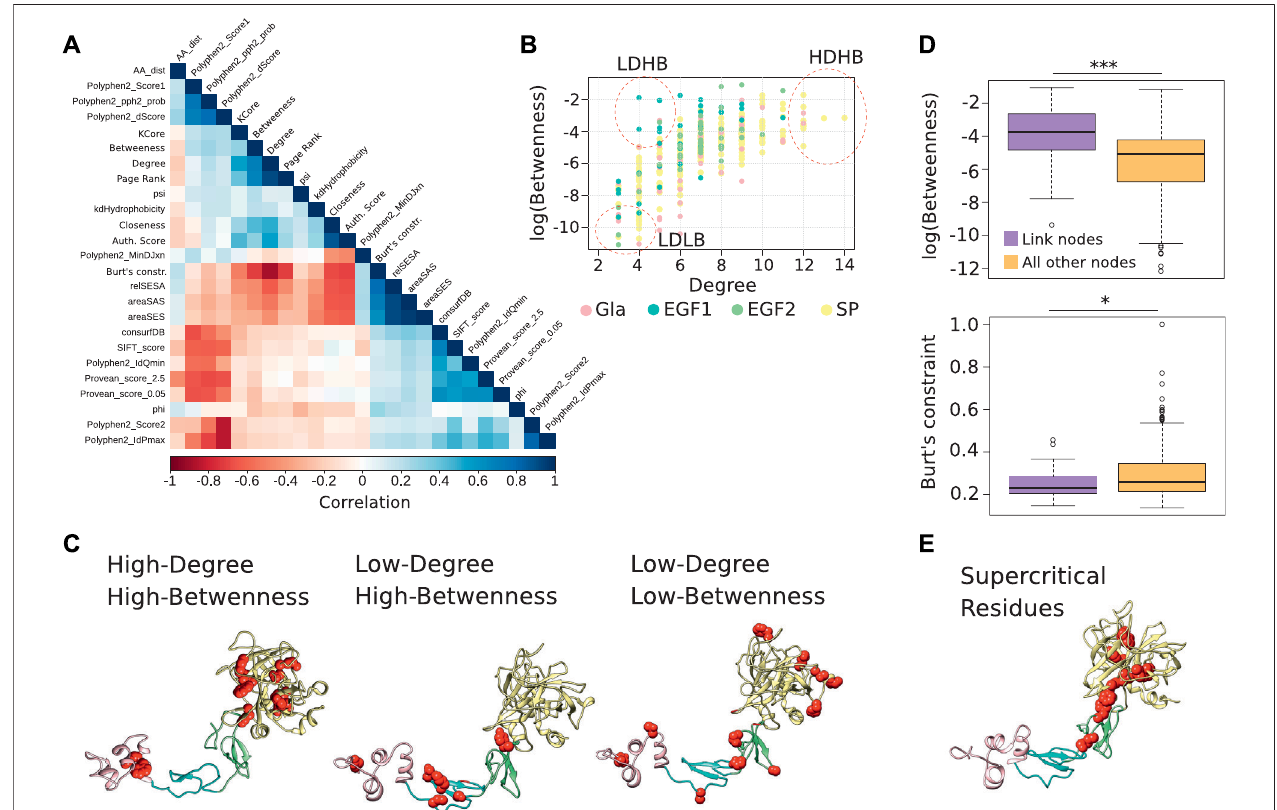
FIGURE 2 | Centrality measures from the FIXa RIN and the important residues. (A) The Spearman correlation between all measures considered in this study. (B) The degree and betweenness of all residues of the FIXa RIN. Each dot represents an amino acid, and groups of residues with different characteristics are highlighted. (C) The location of the residues highlighted in panel (B) in the FIXa protein structure. (D) The boxplot displays the betweenness and the Burt ’ s constraint values of the nodes taking part in atomic interactions with residues in other domains of FIXa (link nodes), compared to the nodes interacting only with residues from the same domain. (E) The residues with the highest degree, betweenness and (lowest) Burt ’ s constraint; these residues are most likely the most central of the whole FIXa protein. The boxplots show the median (center line), the fi rst and third quartiles (lower- and upper-bounds), and 1.5 times the inter-quartile range (lower- and upper whiskers). Unpaired, two-sided Wilcoxon test (*** p -values < 0.001; * p -value < 0.01; * p -value <